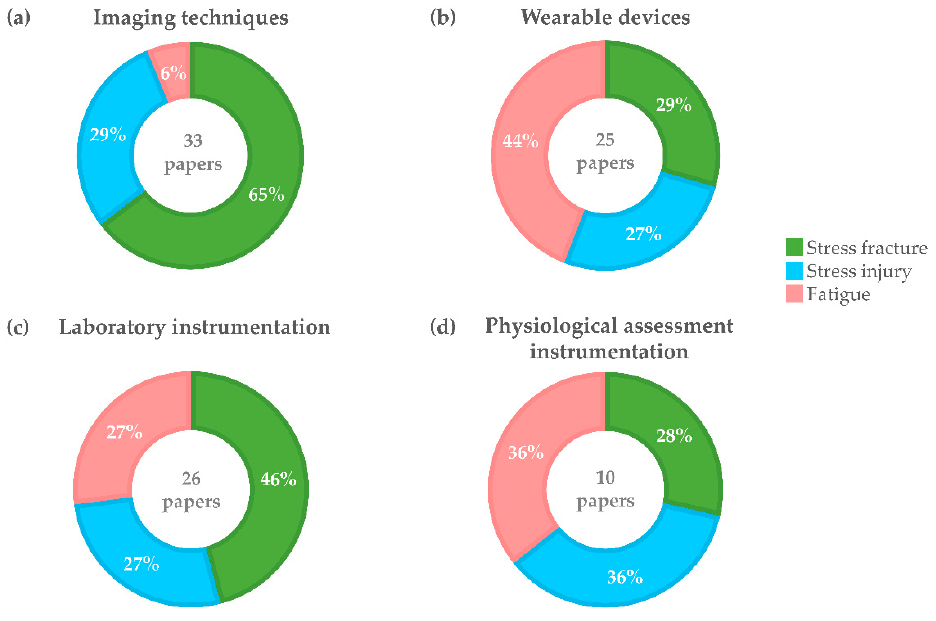
Figure 11. Each ring chart represents one group of instrumentation techniques, namely Imaging techniques ( a ), Wearable devices ( b ), Laboratory instrumentation ( c ) and instru- ments for Physiological Assessment ( d ); percentages within each ring chart refer to the distribution of stress fractures, stress injuries, and fatigue with respect to the total reported in the